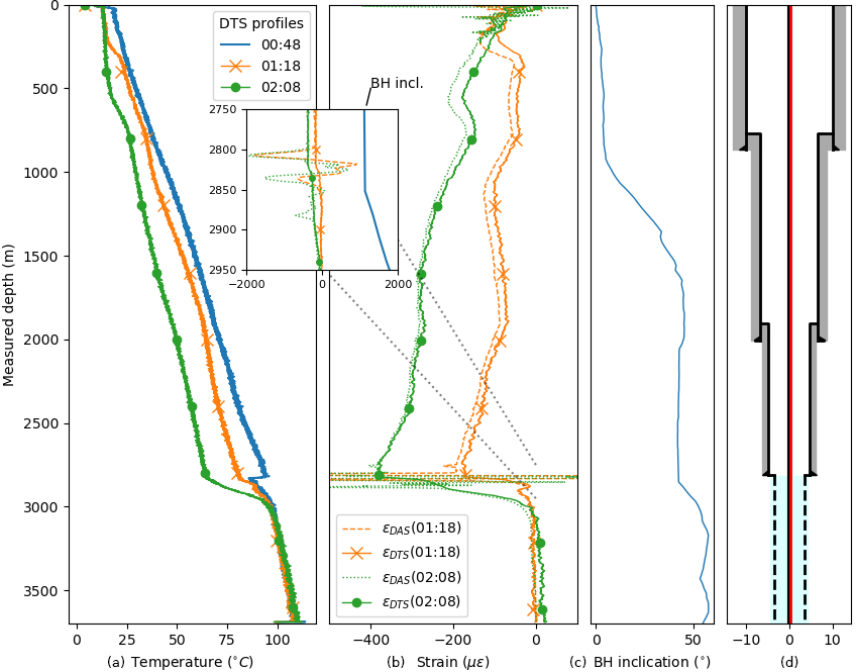
Figure 4. Downhole monitoring data during the cold-water injection test. (a) DTS temperature profiles. (b) Comparison of strain profiles ε DTS and ε DAS . (c) Borehole inclination. (d) Wellbore schematic.